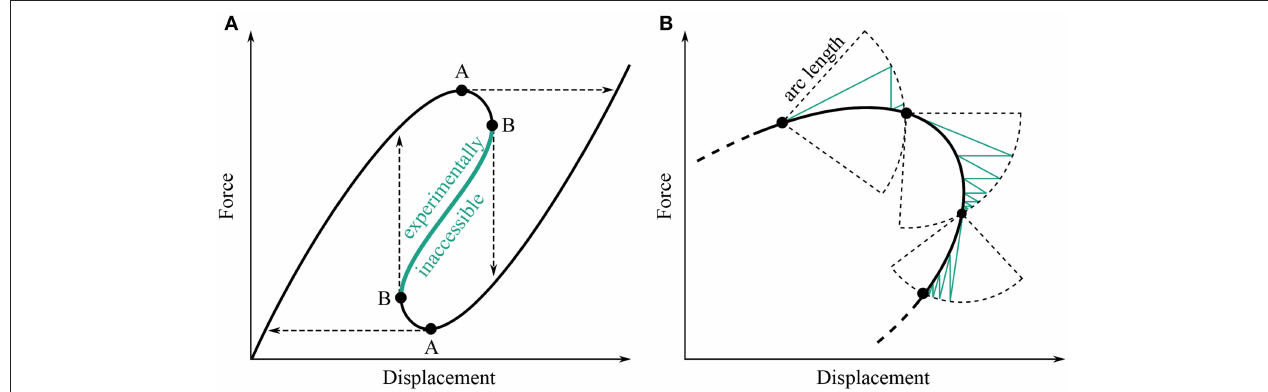
FIGURE 11 | (A) Schematic of a non-linear force-displacement curve featuring both displacement and force limit points. At a force limit point (A) force-controlled test methods snap across. At a displacement limit point (B) displacement-controlled methods snap down. (B) Schematic of an arc length-based numerical solution traversing a displacement limit point. The green line represents the iterative solutions of a Newton-Raphson based method.